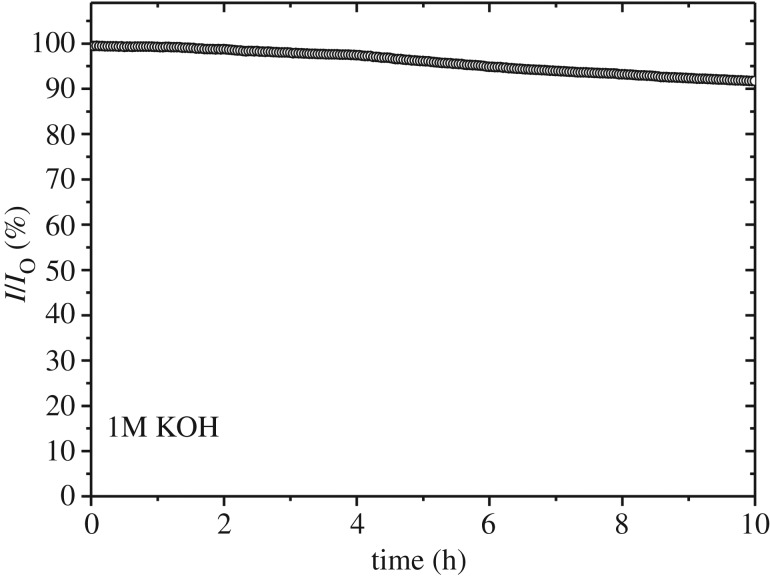
Chronoamperometry curve of NCO-200 under the applied voltage of 1.6 VRHE in 1 M KOH solution.